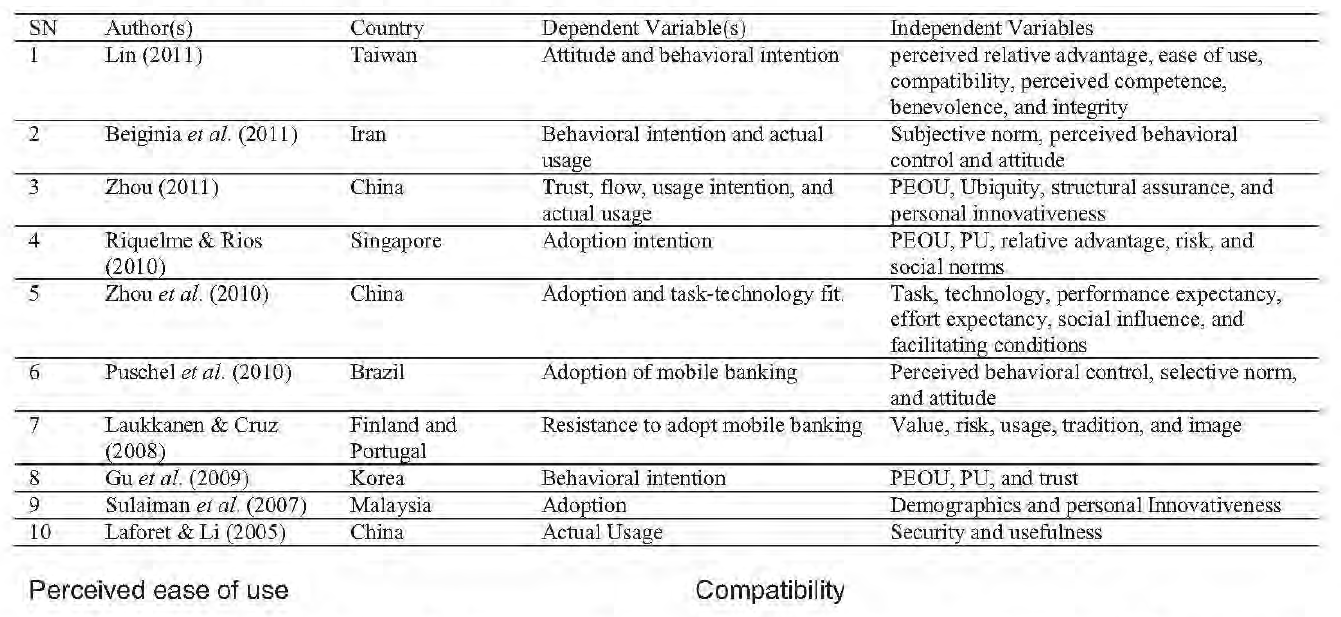
Table 3: Summary of recent research studies on mobile